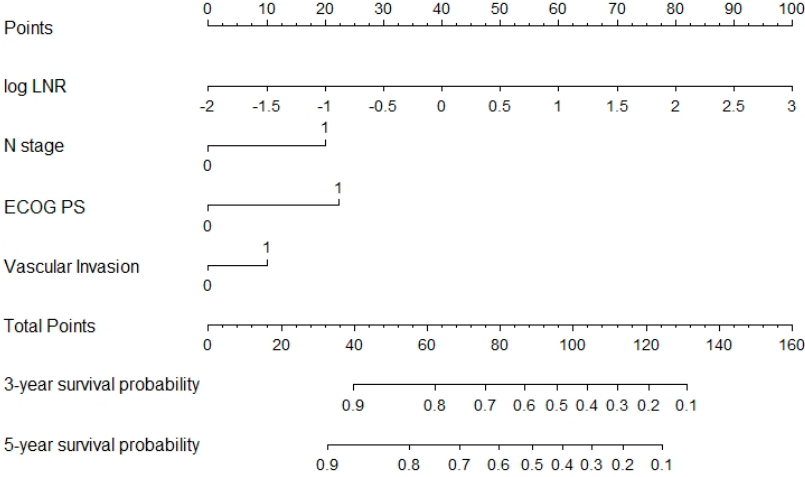
Figure 5. NOMOGAST. A novel nomogram is graphically represented; each variable is listed separately, with corresponding number points assigned to a particular magnitude of the variable. The cumulative point score for all the variables is matched to a scale of the outcome of 3- and 5- year OS.